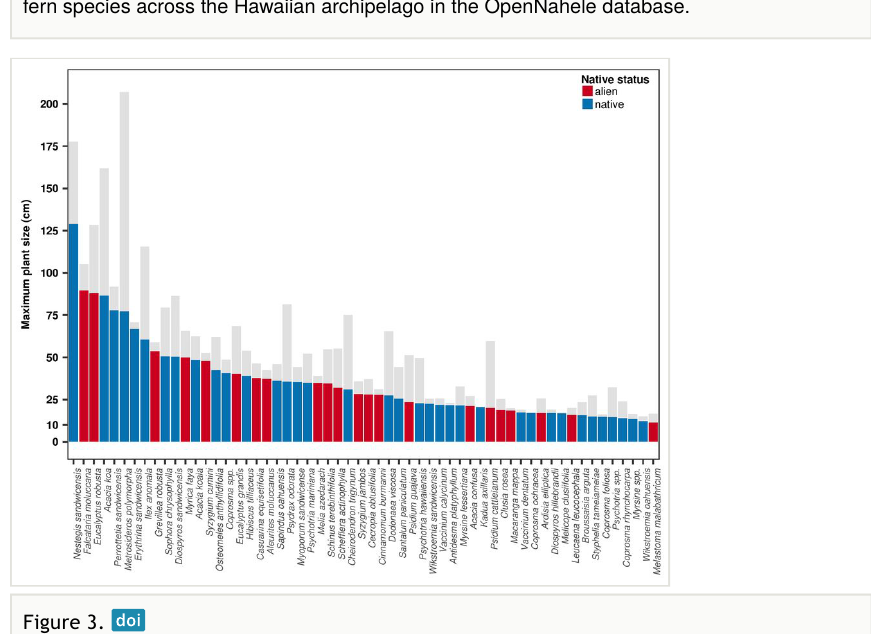
Maximum plant size of 58 plant species across the Hawaiian archipelago. Maximum plant size was estimated from individuals = 5 cm diameter using two methods: i) as D95 (shown in colour), which is the 95th percentile of stem diameter of all diameters = 0.1 x maximum observed diameter and ii) D (shown in light grey), which is the average diameter of the three largest individuals across the OpenNahele database.